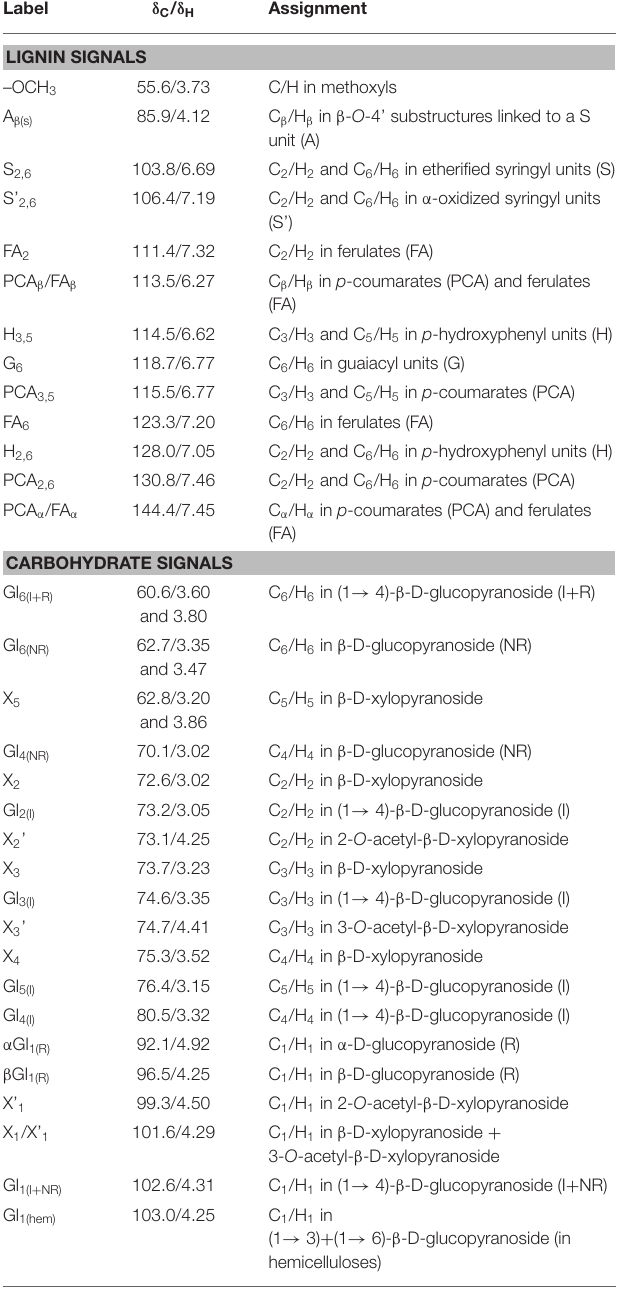
TABLE 4 | Assignment of 13 C/ 1 H correlation of signals in the 2D HSQC NMR